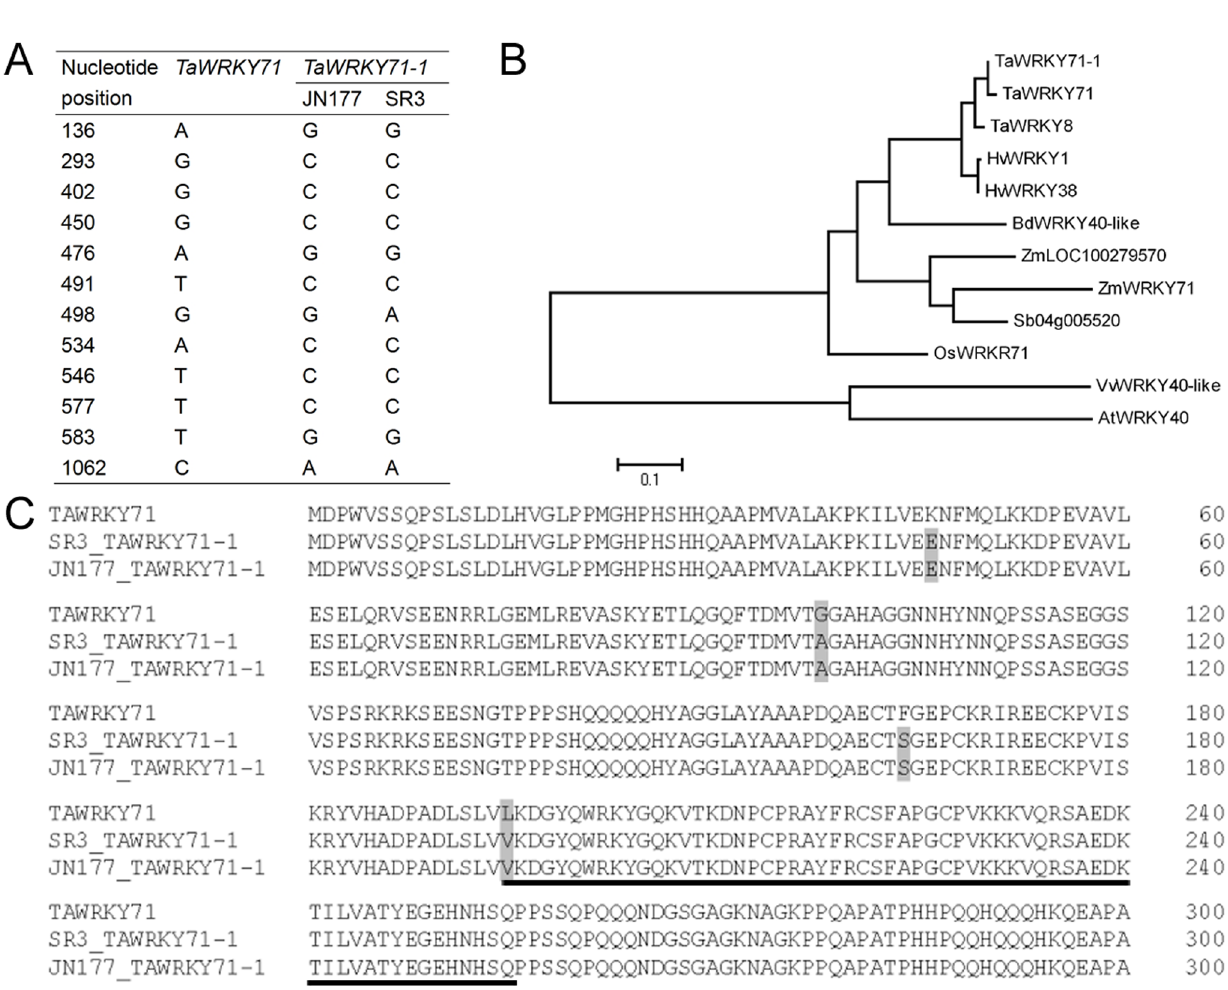
Figure 2. TaWRKY71-1 encodes a group IIa of WRKY transcription factor. A: the statistics of single nucleotide polymorphisms of TaWRKY71-1 from SR3 and JN177 and its homologous gene TaWRKY71 from wheat cultivar Chinese Spring. B: The phylogenetic analysis of TaWRKY71-1 and its aligned WRKY transcription factors from NCBI at the amino acid level. C: Sequence alignment of TaWRKY71-1 from SR3 and JN177and its homologous gene TaWRKY71 from Chinese Spring. Underlined peptide sequence is a WRKY domain. Ta, Triticum aestivum; Hv, Hordeum vulgare; Bd,